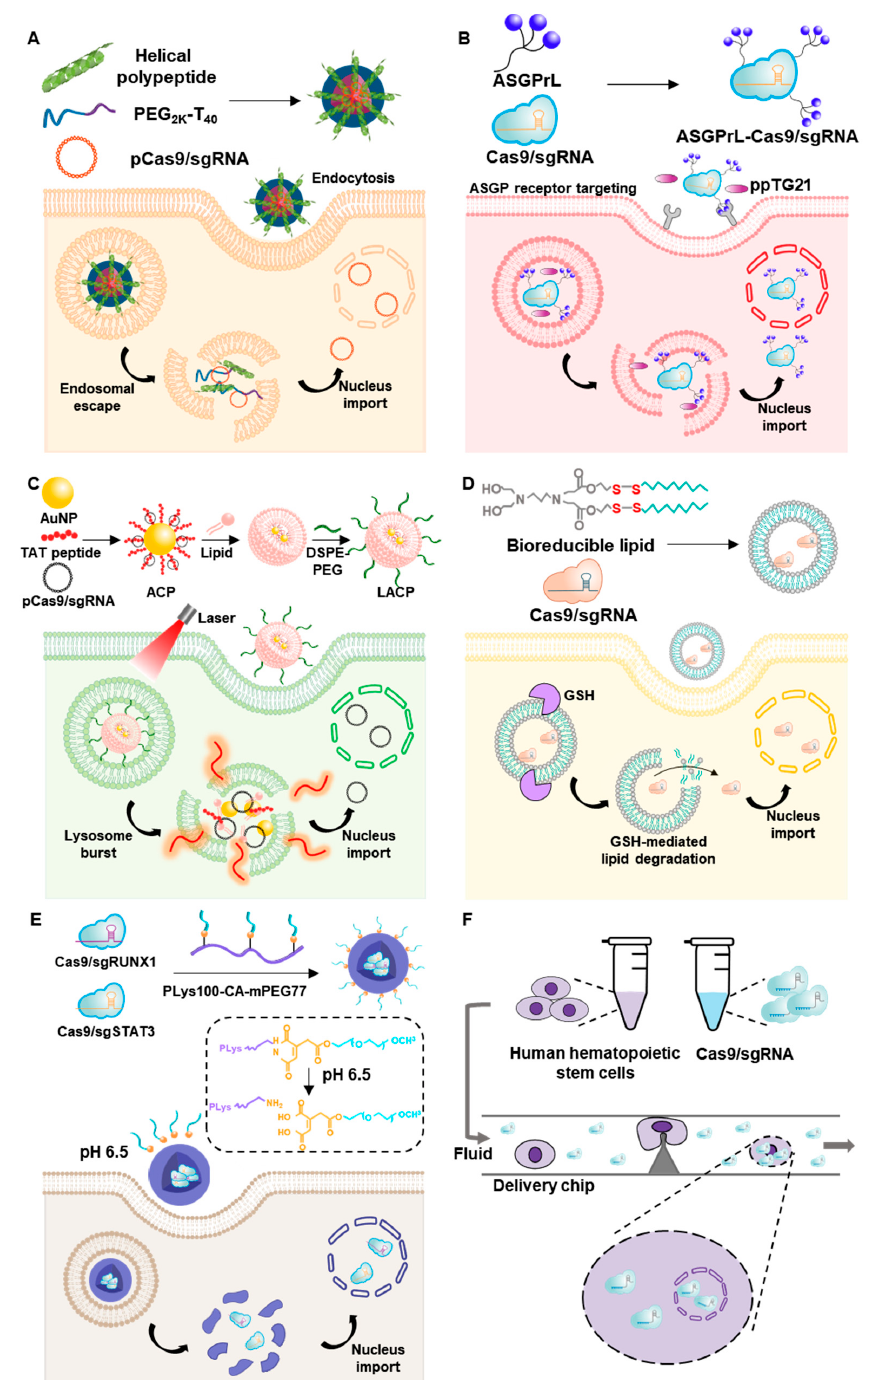
Figure 6. Delivery strategies for CRISPR / Cas9 and sgRNA. ( A ) Helical peptide-mediated endosomal escape. Adapted from [126], PNAS, 2018. ( B ) ASGP receptor targeting nanocomplexes for Cas9 / sgRNA RNP delivery. Adapted from [122], ACS, 2018. ( C ) Photo-responsive liposome for pCas9 delivery. Adapted from [127], WILEY-VCH, 2018. ( D ) GSH-responsive lipid-containing liposome for Cas9 / sgRNA RNP delivery. Adapted from [128], PNAS, 2016. ( E ) pH-responsive polymeric nanoparticle for Cas9 / sgRNA RNP delivery. Adapted from [129], ACS, 2019. ( F ) Physical delivery of Cas9 / sgRNA RNP using a microfluidic chip system. Adapted from [130], RSC,